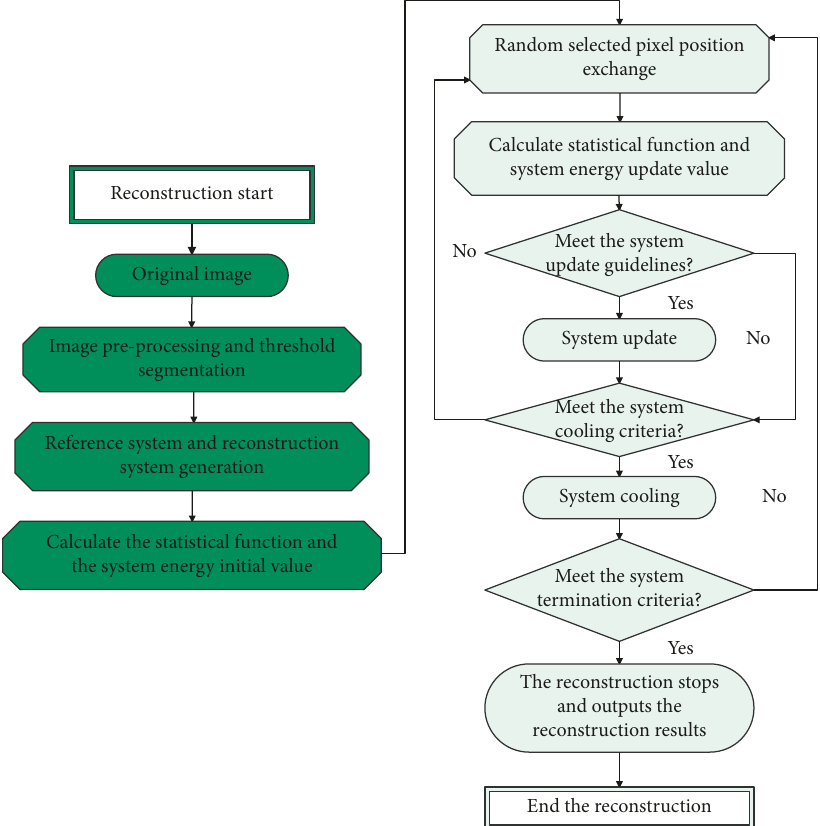
Figure 1: Flowchart of the conventional simulated annealing